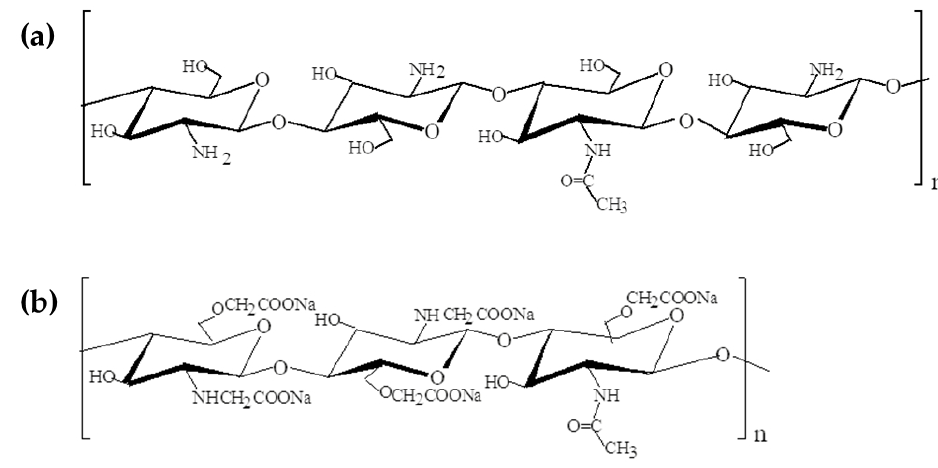
Figure 1. Structures of chitosan ( a ) and carboxymethyl chitosan ( b ).